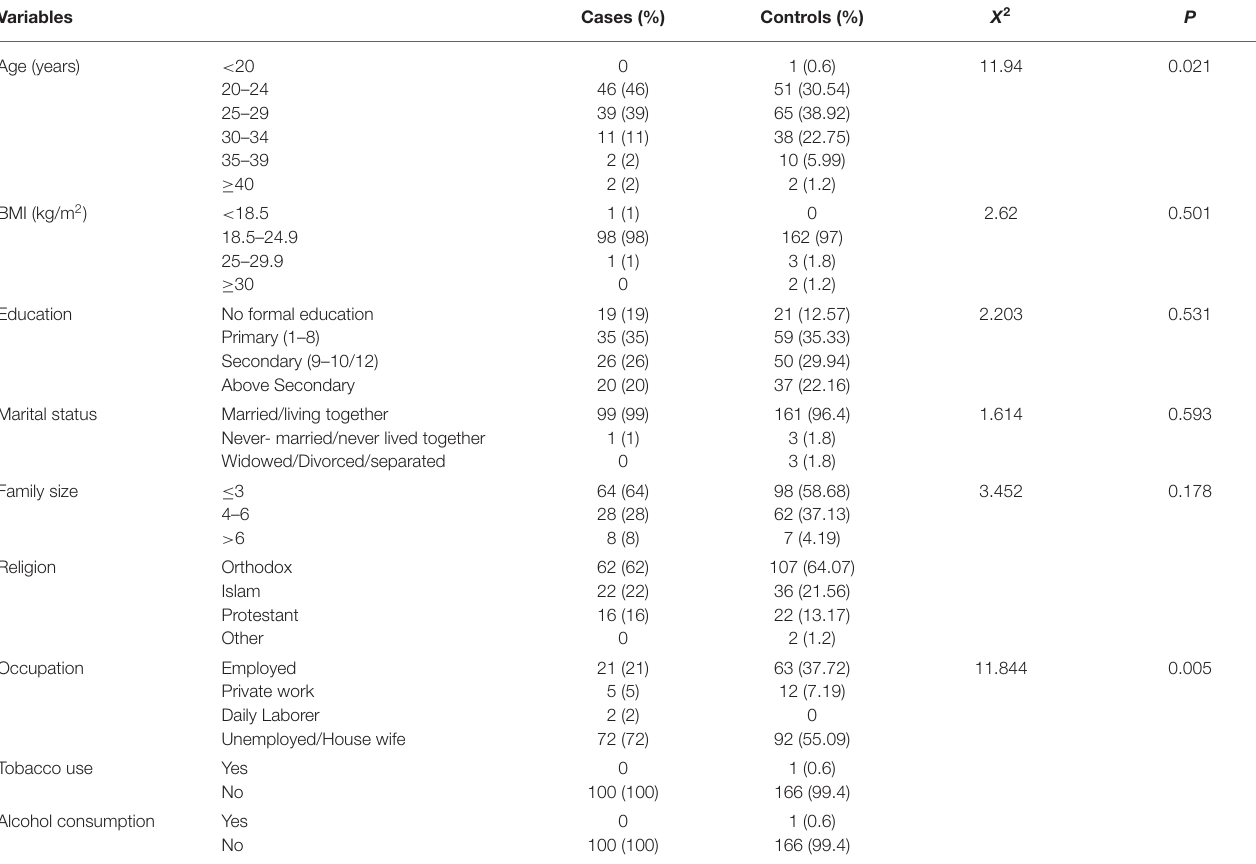
TABLE 1 | Socio-demographic characteristic of the study participants in three selected hospitals in Addis Ababa, Ethiopia, between September 2019 and August 2020. Variables Cases (%) Controls (%) X 2